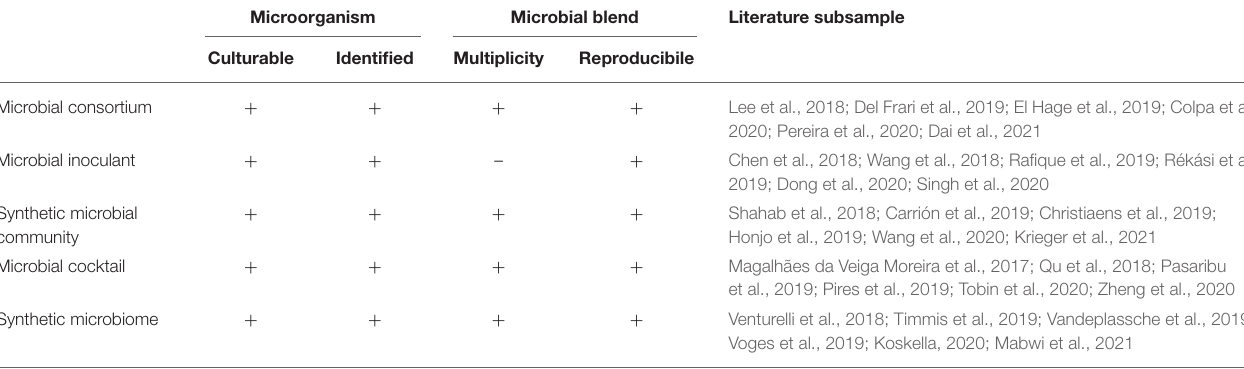
TABLE 1 | Terms frequently used to identify microbial blends and associated key